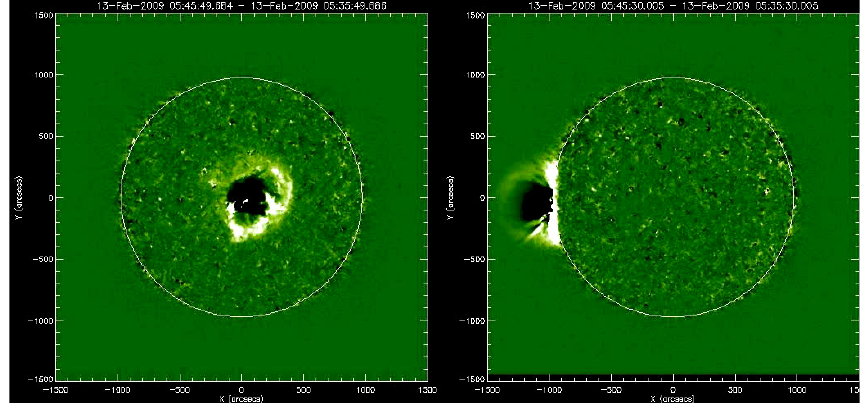
Figure 36: Still from a movie – An animation of the 2009 Feb 13 coronal wave observed in quadrature with STEREO-B ( left ) and STEREO-A ( right ). Shown are EUVI 195 ˚A running difference images. Reproduced with permission from Kienreich et al. (2009), copyright by AAS. (To watch the movie, please go to the online version of this review article at http://www.livingreviews.org/lrsp-2015-3